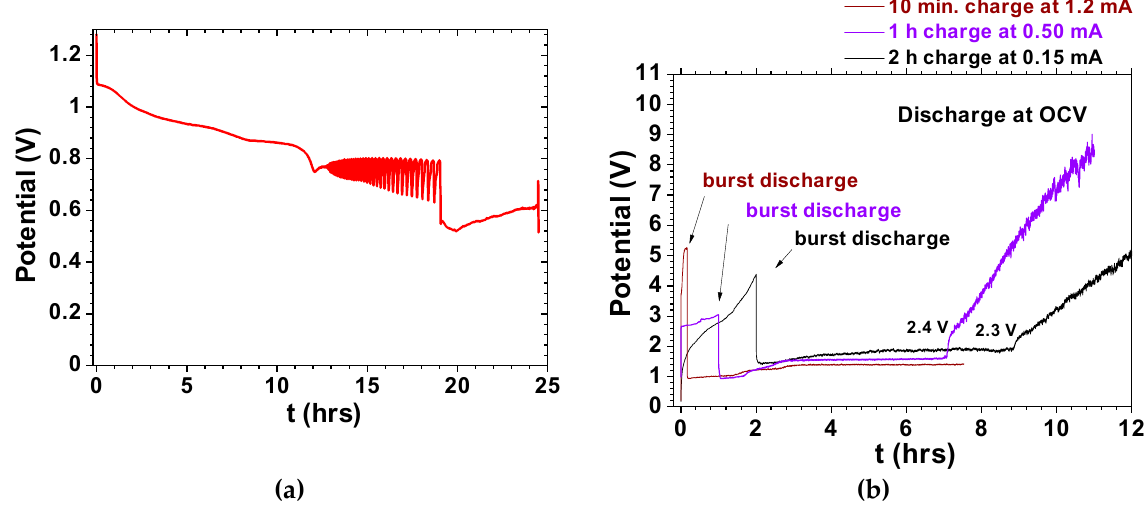
Figure 3. conductor 1 /ferroelectric-electrolyte/conductor 2 cells showing self-charging and self-cycling while the cell is set to discharge. ( a ) Zn/ferroelectric-electrolyte (Na 2.99 Ba 0.005 ClO)/C + Cu cell showing bifurcations corresponding to self-cycling while discharging with a resistor of 1000 Ω at 60 ° C as in Figure 1e (adapted from [70]); ( b ) Cu/ferroelectric-electrolyte (Na 2.99 Ba 0.005 ClO)/Cu cell after quick charge followed by discharge at open-circuit voltage to 1.1–1.3 V, for then self-charging to 2.3–2.4 V after 6 or 8 h up to approximately 9 or 5 V, respectively (adapted from [65]).